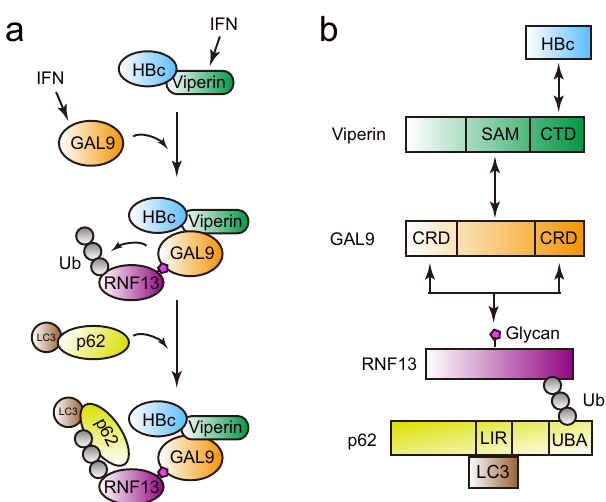
Fig. 7 Model of GAL9-induced HBc degradation. a Molecular mechanism of selective autophagy of HBc by GAL9. Type I IFN induces expression of GAL9 and viperin, which bind to RNF13 and HBc, respectively. Viperin binds to HBc and GAL9, leading to the HBc-puncta formation. Auto-ubiquitination of RNF13 is enhanced by GAL9, and autophagosome formation occurs when p62 is recruited. b Detailed binding mechanism. Viperin binds to GAL9 and HBc in the SAM and C-terminal domains, respectively. The CRD domain of GAL9 is important for binding to RNF13 carbohydrate chains. Ubiquitination of RNF13 is recognized by the UBA domain of